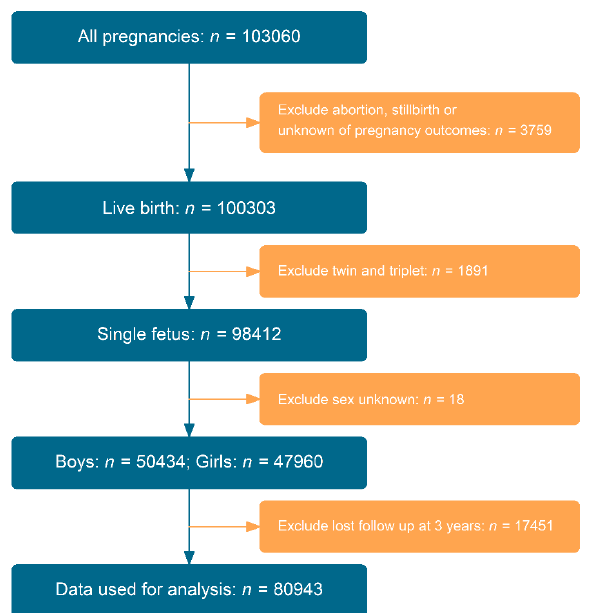
Figure 1. Flow chart of study cohort.